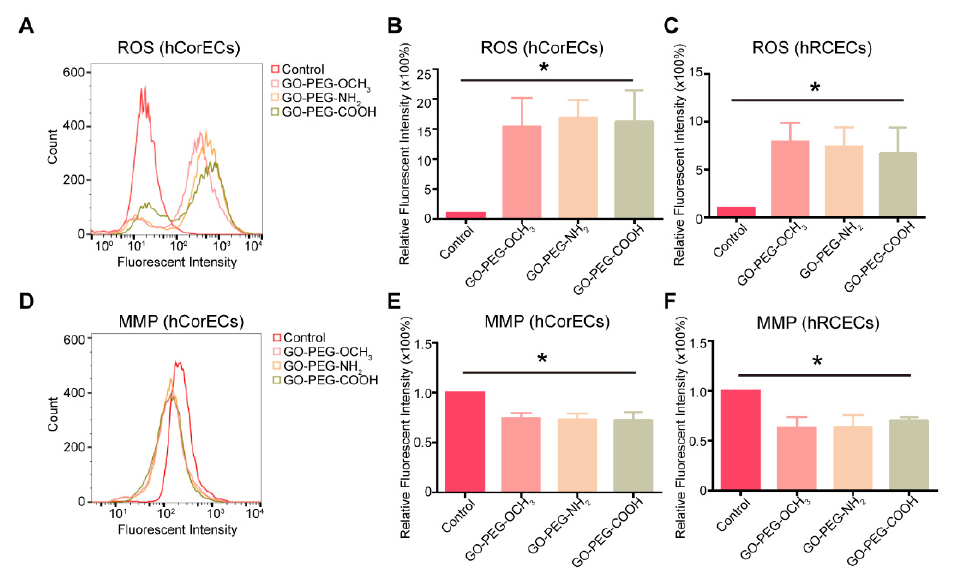
Figure 2. Cellular biochemical reactions of hCorECs and hRCECs exposed to PEG-GO nanosheets with different surface charges. ( A ) Fluorescence activated cell sorting (FACS) analysis of intracellular reactive oxygen species (ROS) in PEG-GO-treated hCorECs. ( B , C ) Group data of intracellular ROS (relative fluorescence intensity) of PEG-GO-treated hCorECs or hRCECs. ( D ) FACS analysis of mitochondrial membrane potential (MMP) in PEG-GO-treated hCorECs. ( E , F ) Group data of MMP (relative fluorescence intensity) of PEG-GO-treated hCorECs or hRCECs. The absence of PEG-GO samples served as the control. Bars show mean ± S.D. compared with control group: * p < 0.05.